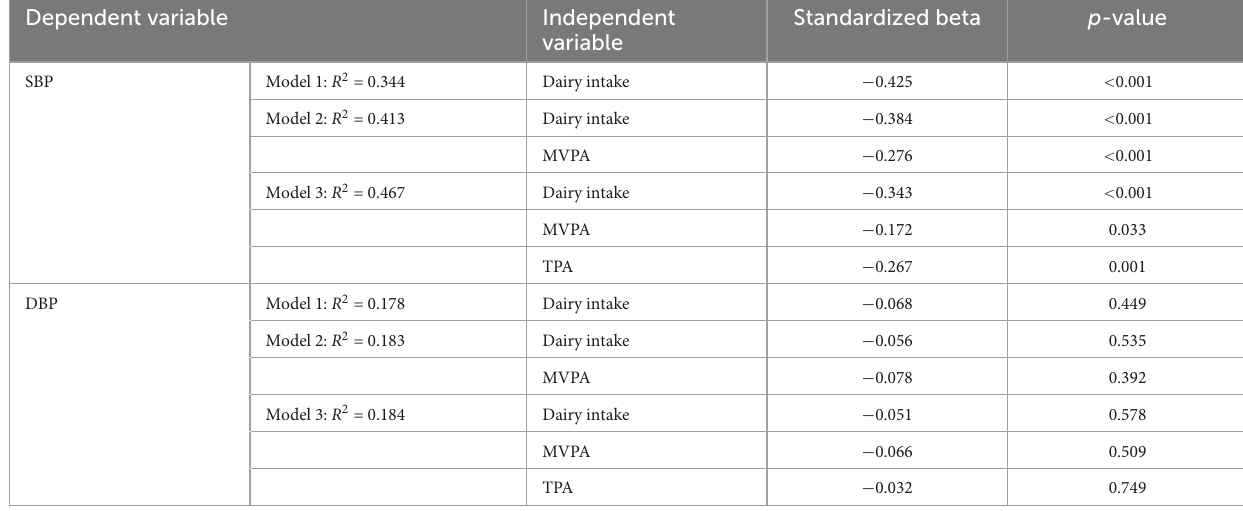
TABLE 4 Standardized regression coefficients of dairy intake, MVPA, and TPA for BP measures (without controlling for personality data). Dependent variable Independent Standardized beta p variable